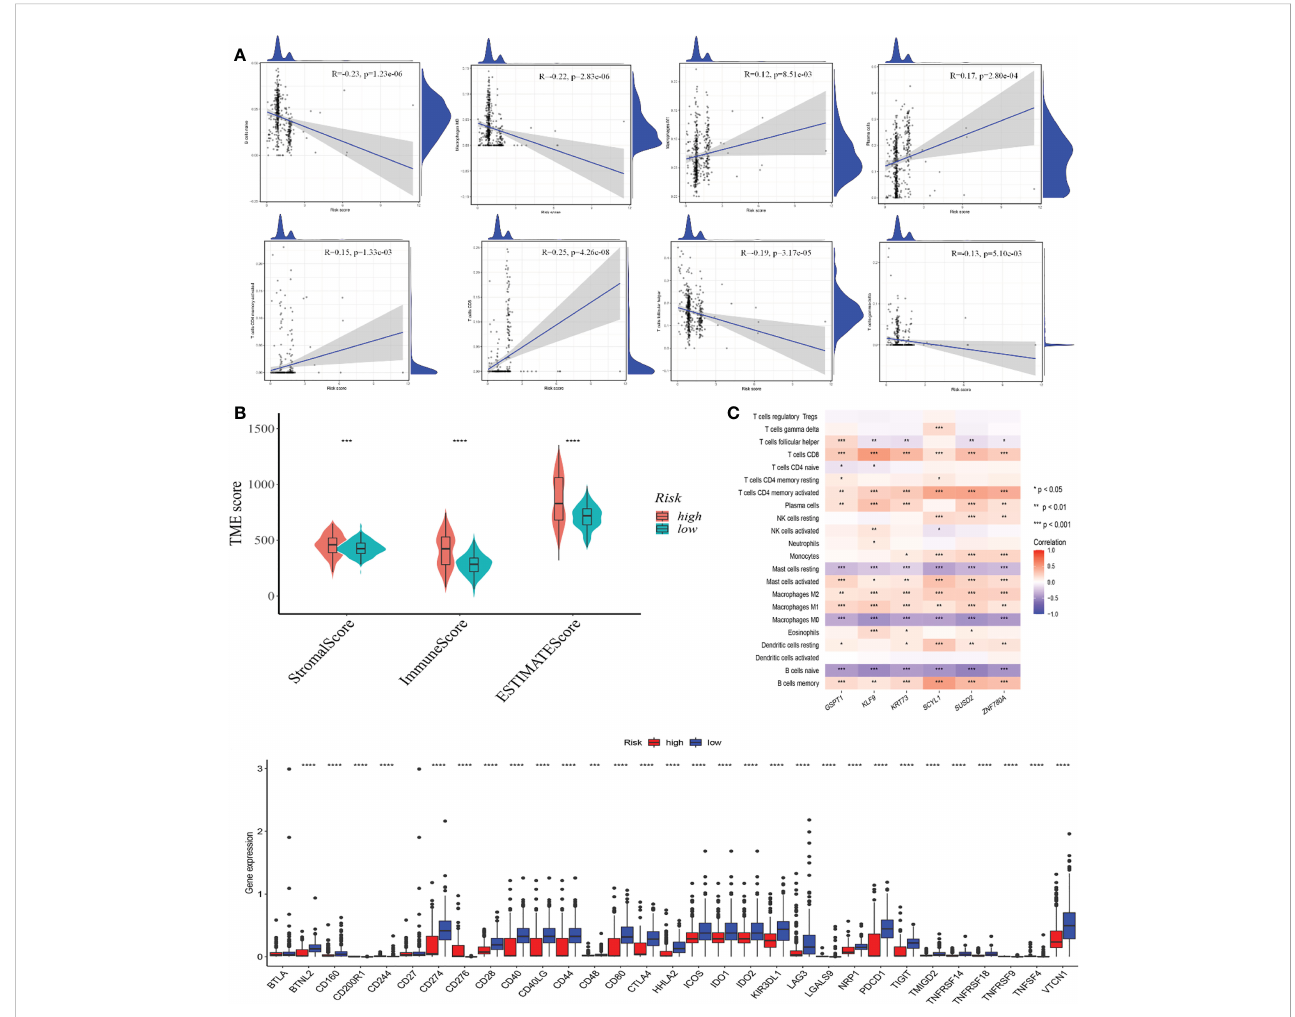
FIGURE 7 (A) TME evaluation and checkpoints between the two classes Correlations between CRG scores and immune cell types. (B) Relationships between CRG and immune and stromal scores. (C) Correlations between immune cell abundance and seven genes in the proposed model. (D) Immune checkpoint expression in high and low-risk groups. TME, tumor microenvironment. *p-value<0.05, **p-value<0.01, ***p-value<0.001,